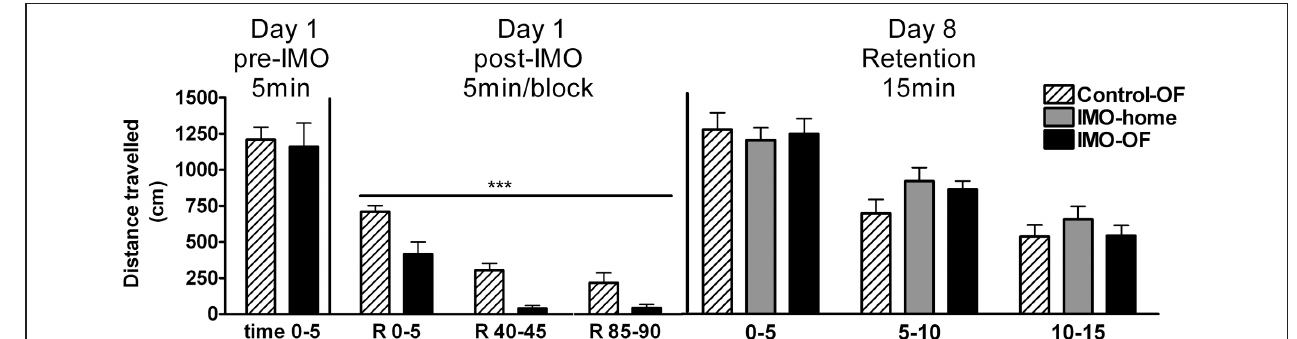
FIGURE 4 | Distance traveled in an open field (OF) for Experiment 2 on day 1 (pre-IMO and post-IMO period) and day 8 (retention). Means and SEM are represented. The groups were: control-OF, which were exposed to the OF for 5min, left undisturbed in their home-cages in the animal room for 25min and then returned to the OF for an additional 90min period (R 0–90); IMO-home, which were allowed to explore the OF for 5min, then exposed to